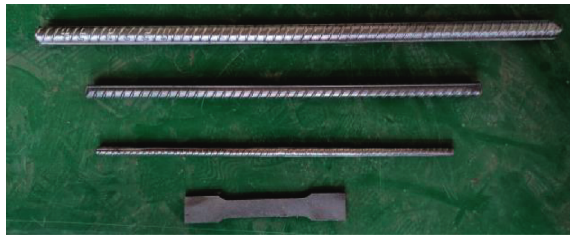
Figure 1: Testing rebar and steel